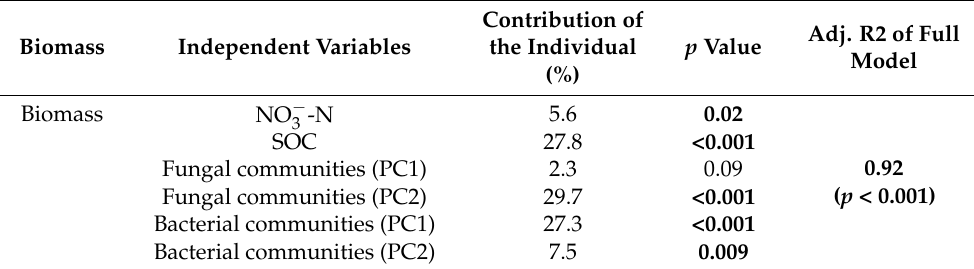
Table 2. Results of the stepwise multiple regression using the best subset model for the effect of different soil nutrient contents and biotic (bacteria and fungi) factors on the biomass.